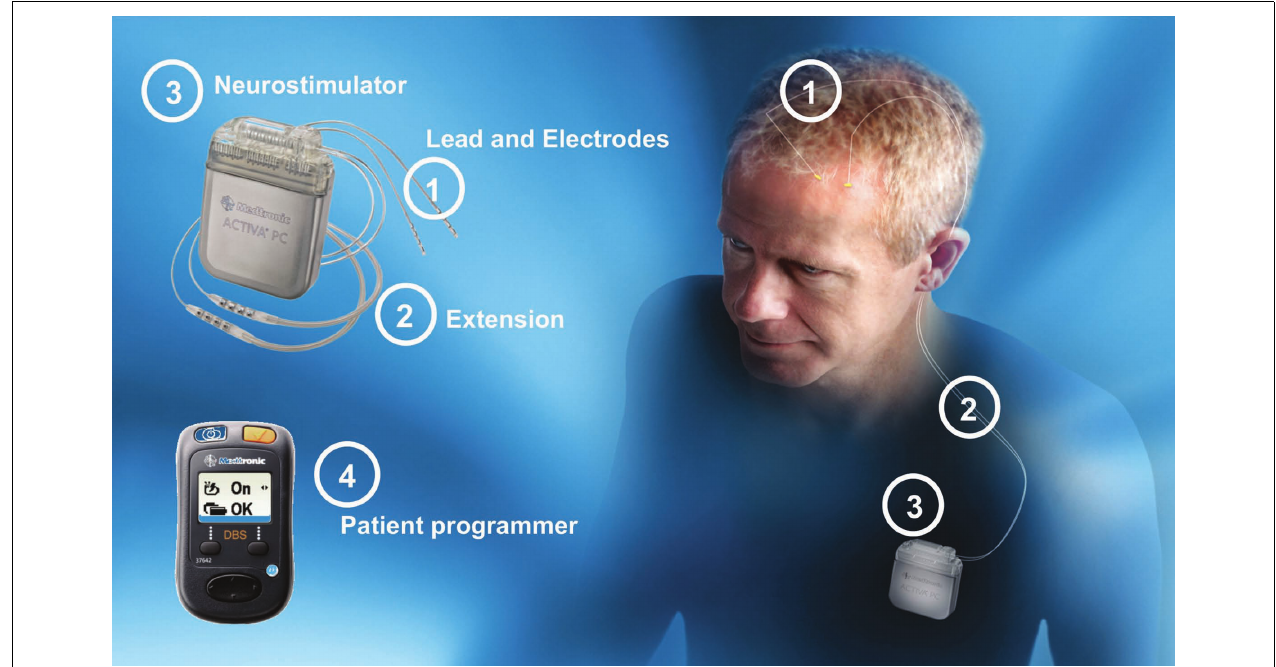
FIGURE 1 | Deep Brain Stimulator SystemTypeActiva ® PC (primary cell). The patient programmer may perform device status interrogation (e.g., power status, program group, battery status, and on/off function).